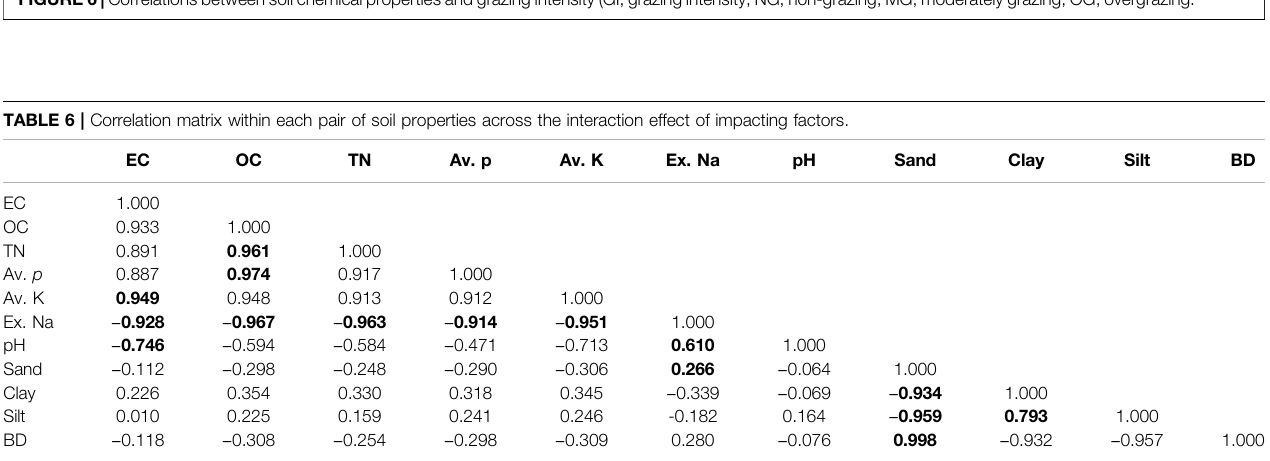
FIGURE 6| Correlations between soil chemical properties and grazing intensity (GI, grazingintensity; NG, non-grazing; MG, moderately grazing; OG, overgrazing.